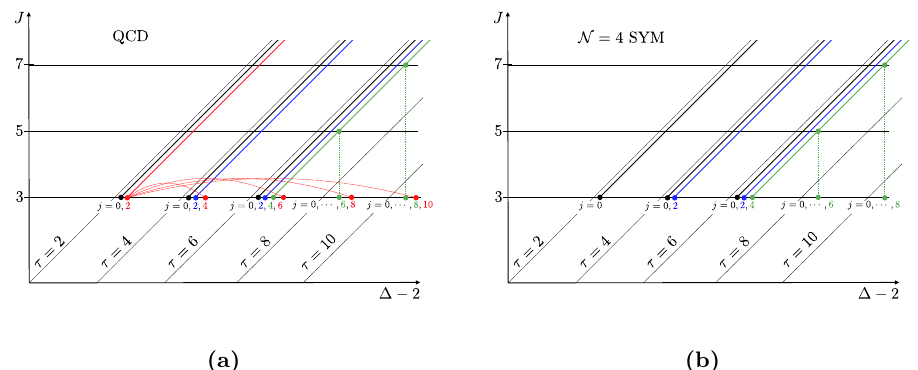
Figure 2. Chew-Frautschi plot relevant for the squeezed limit of the three-point correlator in QCD, (a), and in N = 4 SYM, (b). As compared to the structure in a generic field theory, at leading order in the perturbative expansion, one does not have contributions from j = 4 operators at twist-2 or twist-4. This has the consequence that in QCD, the highest transverse spin terms at each twist are descendants of the twist-2 j = 2 operator. In N = 4 , supersymmetry eliminates these contributions, leading to a simplified spectrum of operators. A more detailed discussion is presented in the